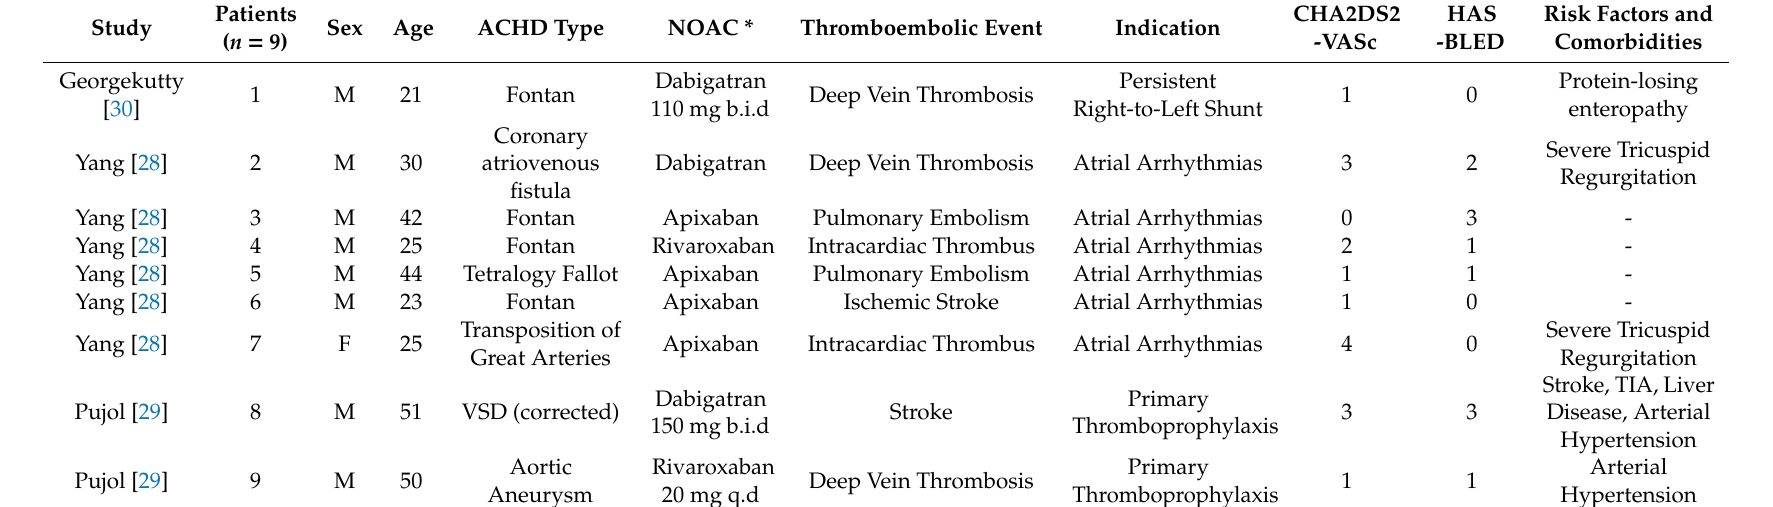
Table 5. Descriptive characteristics of patients with thromboembolic